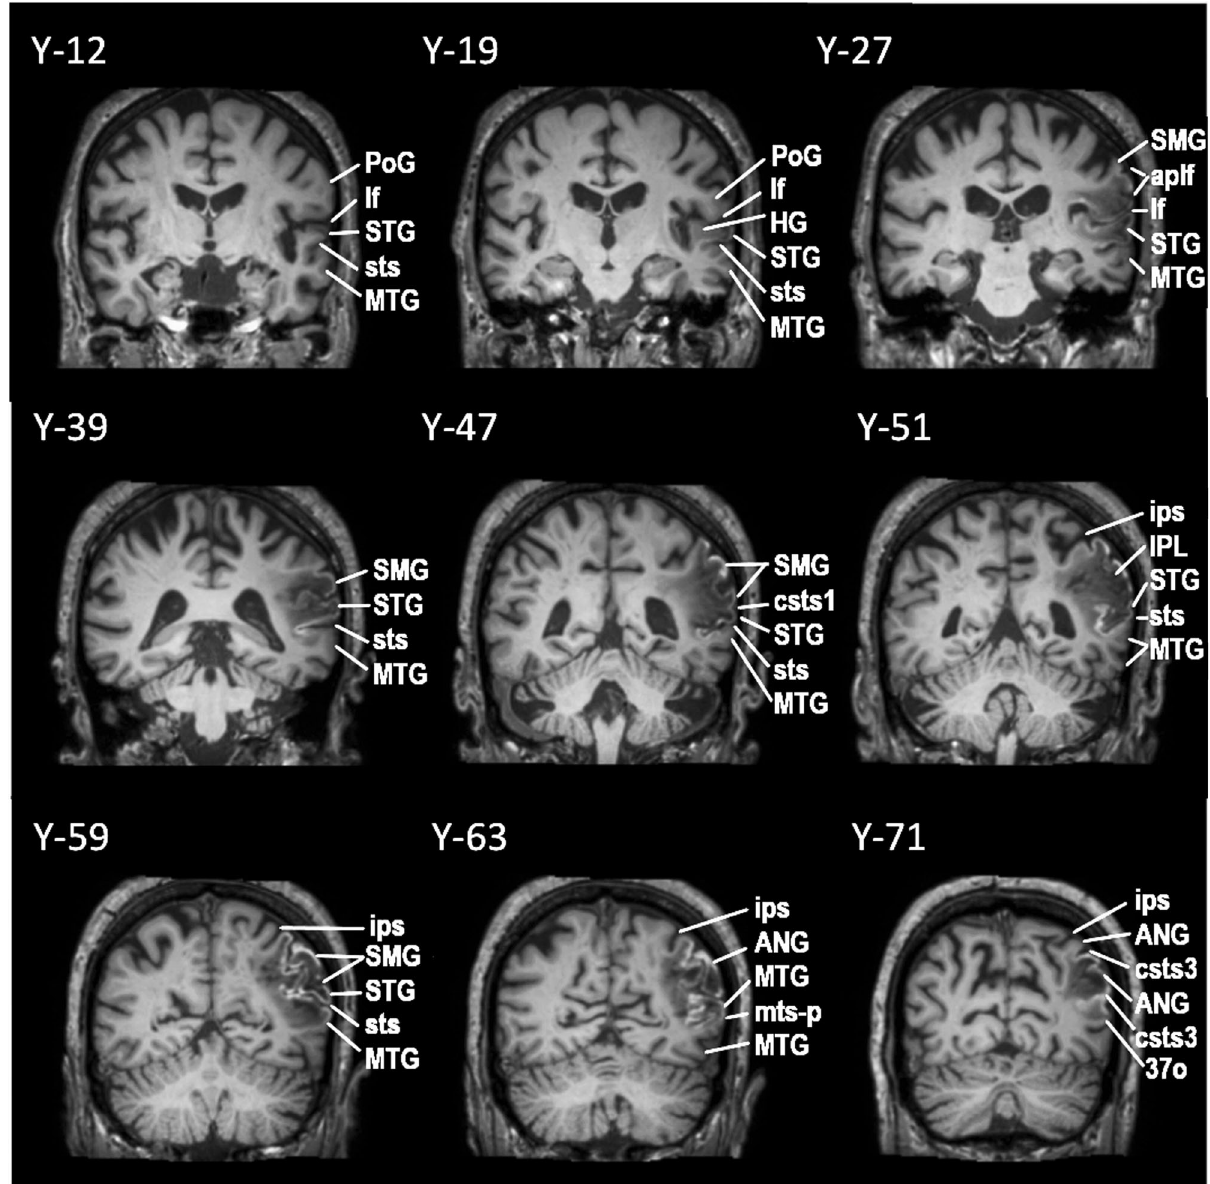
Fig. 3 Successive coronal MRI images in MNI stereotaxic coordinates (Y) depicting the lesion of patient MM with damage to the dorsal posterior language region. The lesion fi rst appears below the central sulcus, just posterior to the sulcus acousticus, at Y-12, where a small part of the STG is damaged. At approximately Y-19, there is damage to both the planum temporale, where HG lies and the lateral part of the STG, including both banks of the sts (involving the classic Wernicke region). At Y-27, there is complete damage to HG, planum temporale, the entire STG and both banks of sts. At this level, one observes damage to the parietal operculum and the anterior part of SMG (area PF). At Y-39, there is still damage to the entire STG, including both banks of the sts. The parietal operculum, and the ventral part of SMG are completely destroyed, as well as the underlying white matter, which affected fi bers from both the SLF III and AF. Further posteriorly, at Y-47, the entire SMG, STG and both banks of sts, as well as the underlying white matter is destroyed. At Y-51, the lesion includes the entire STG and both banks of the sts. The lesion extends from the ips, down to the posterior temporal lobe. Thus, all of the SMG was damaged including the adjacent STG and the upper part of adjacent MTG. At Y-59, again there is damage in the SMG gyrus and the underlying white matter. The damage extends from the ips as far as the posteriormost part of the adjacent MTG. At Y-63, the lesion extends below the ips including the ANG and MTG, until the mts-p. Between Y-71 and Y-79, the lesion includes the ANG from the intraparietal sulcus as far ventral as the csts-3. Brain areas are topologically de fi ned according to the atlas of the morphology of the human cerebral cortex in the MNI Stereotaxic Space 67 . ANG angular gyrus; aplf ascending posterior ramus of the lateral fi ssure; csts1 caudal superior temporal sulcus, branch 1; csts3 caudal superior temporal sulcus, branch 3; HG Heschl ’ s gyrus; IPL inferior parietal lobule; ips intraparietal sulcus; lf lateral fi ssure; MTG middle temporal gyrus; mts-p posterior middle temporal sulcus; PoG postcentral gyrus; SMG supramarginal gyrus; STG superior temporal gyrus; sts superior temporal sulcus. COMMUNICATIONS BIOLOGY| (2022) 5:1077